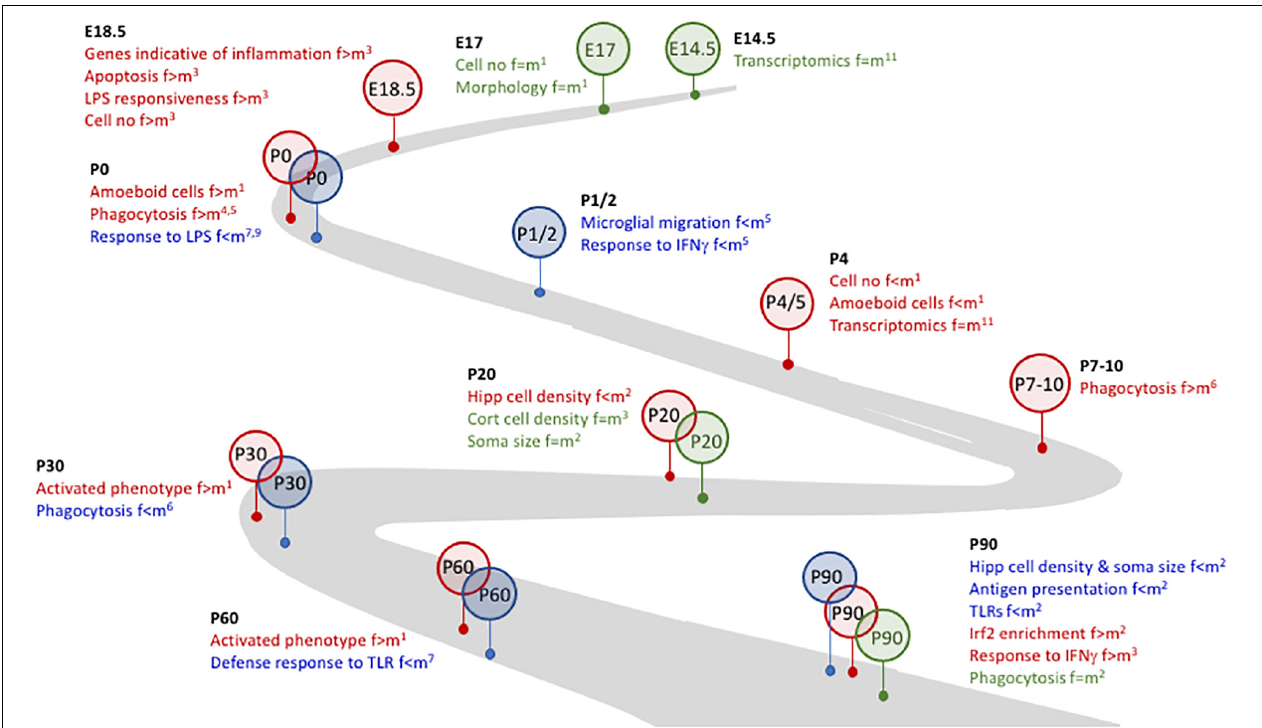
FIGURE 1 | Microglial plasticity is characterized by dynamic changes in early life. Several changes in microglia during development and early life are sex-related. For example. Whereas no marked differences (identified in green) between females and males were identified at E14.5 and E17, at E18.4 changes that were indicative of inflammatory microglia were evident in female, but not male, mice and cells from female mice were more responsive to LPS. By P0, microglia from female mice were more phagocytic and amoeboid (identified in red) but were less responsive to LPS than male mice, suggesting that microglia from female mice may be desensitized to at least some inflammatory stimuli. At P1/2, microglia from male mice (identified in blue) were more motile and more responsive to IFN γ . The timeline to P90, as indicated, is marked with sex-related differences in microglia number and/or function and/or inflammation. References: 1 Schwarz et al., 2012; 2 Guneykaya et al., 2018; 3 Thion et al., 2018; 4 Nelson et al., 2017; 5 Yanguas-Casas et al., 2018; 6 Weinhard et al., 2018; 7 Hanamsagar et al., 2017; 8 Villa et al., 2018; 9 Loram et al., 2012; 10 Gal-Oz et al., 2019; 11 Hammond et al.,